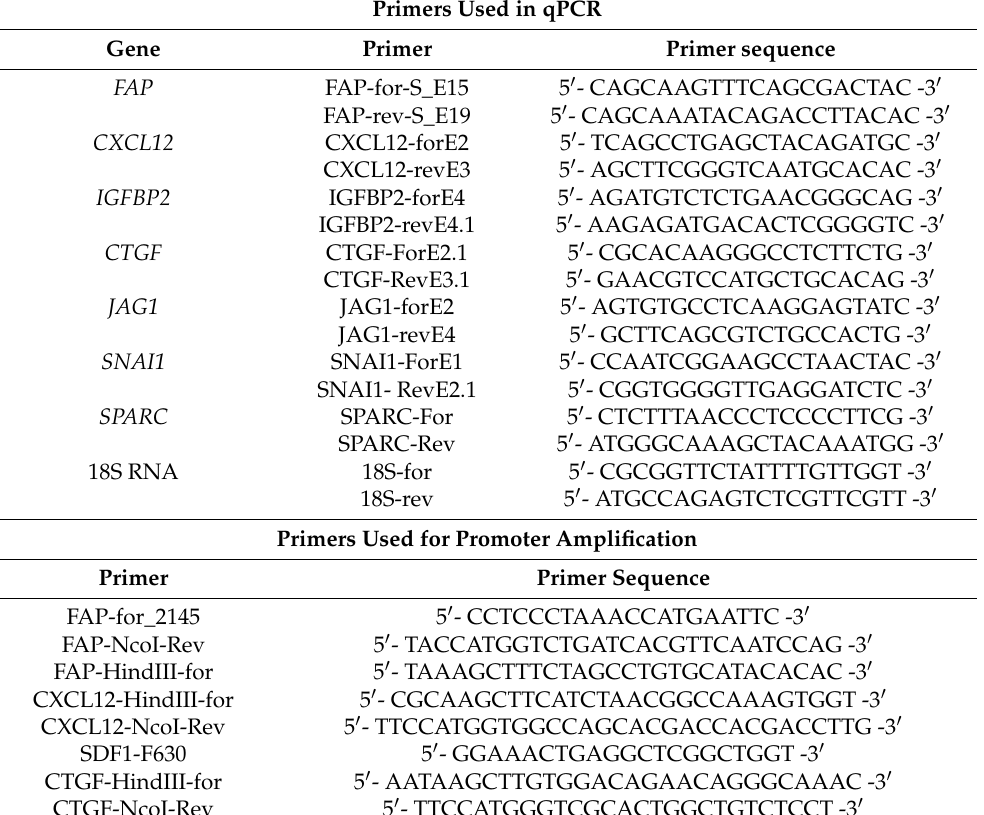
Table 2. Primers used in the